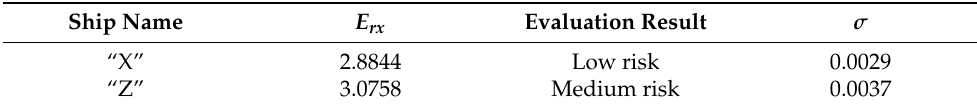
Table 14. Final evaluation result for “X” and